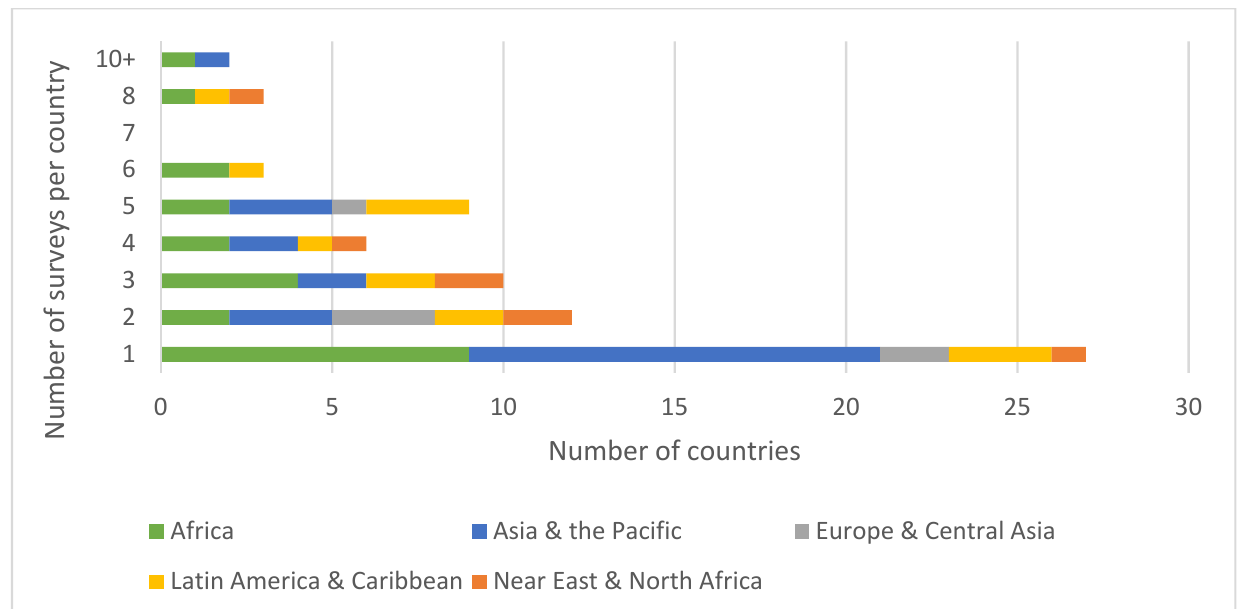
Figure 2. Number of surveys conducted in the period during 1980–2019 per LMIC in different geographical regions. Data shown reflect the situation as of May 2022. Geographic regions are defined according to the FAO operational classification. Only LMICs are included for all regions, including Europe and Central Asia.